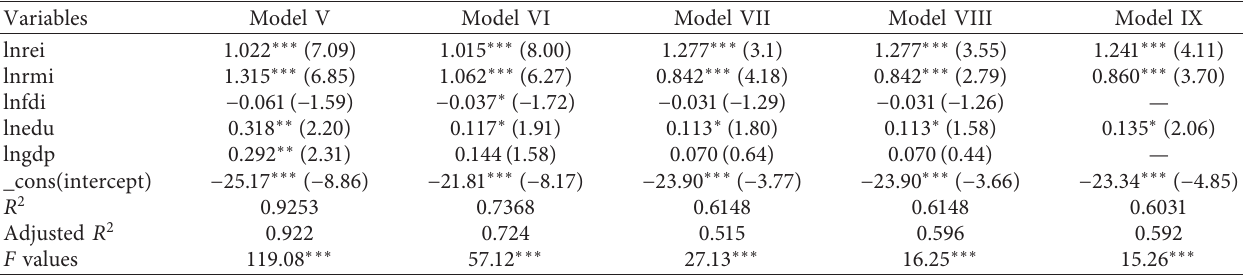
Table 6: The regression results of R&D input and patent